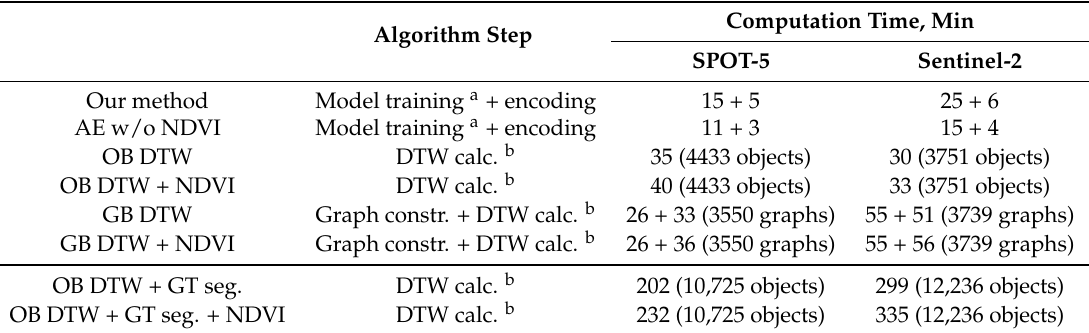
Table 5. Computation